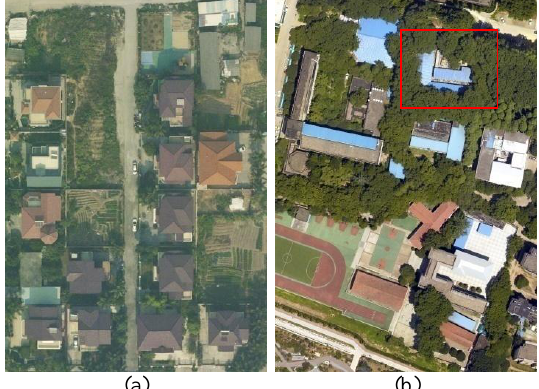
Figure 6. Ortho images of the two test sites: (a)Yangjiang and (b)Wuhan.